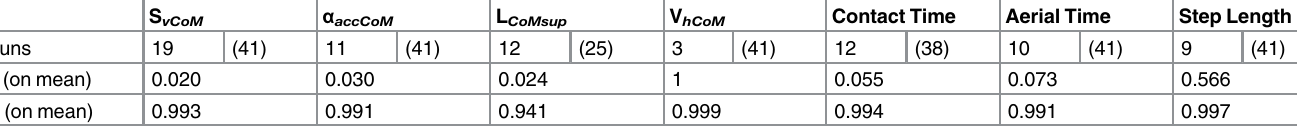
Table 1. Comparison of piecewise linear/exponential and exponential curve fitting.